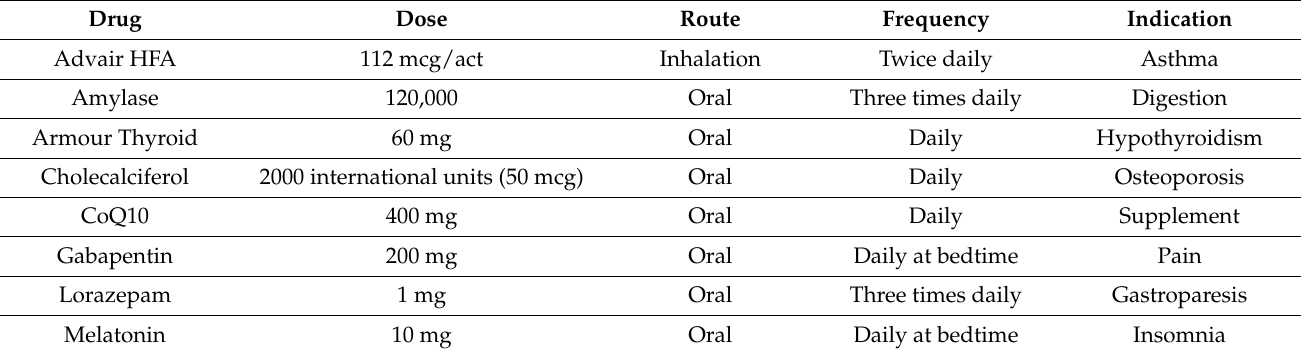
Table 1. Medication List at Initial